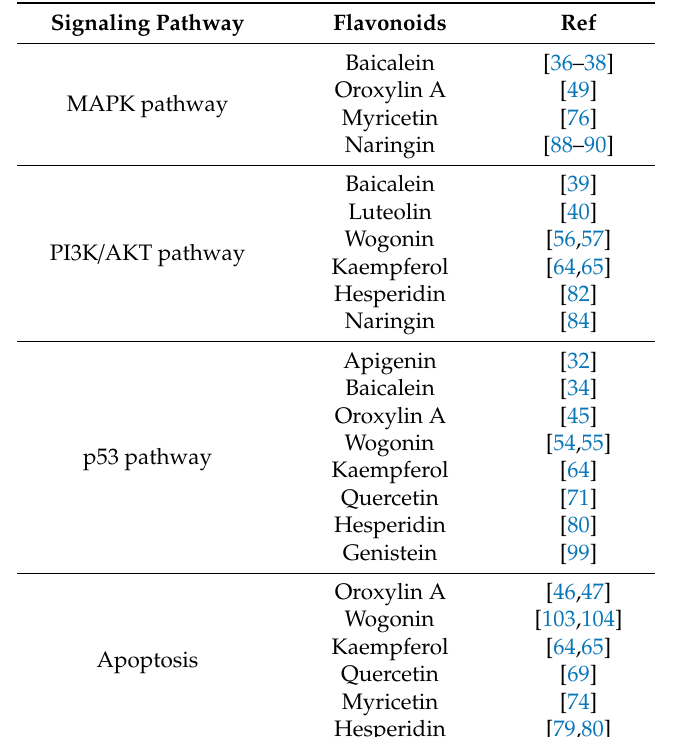
Table 2. Common signaling pathways triggered by flavonoids for anticancer e ff